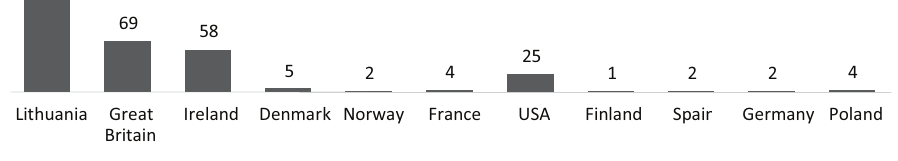
fig. 2. Country of residence, N =